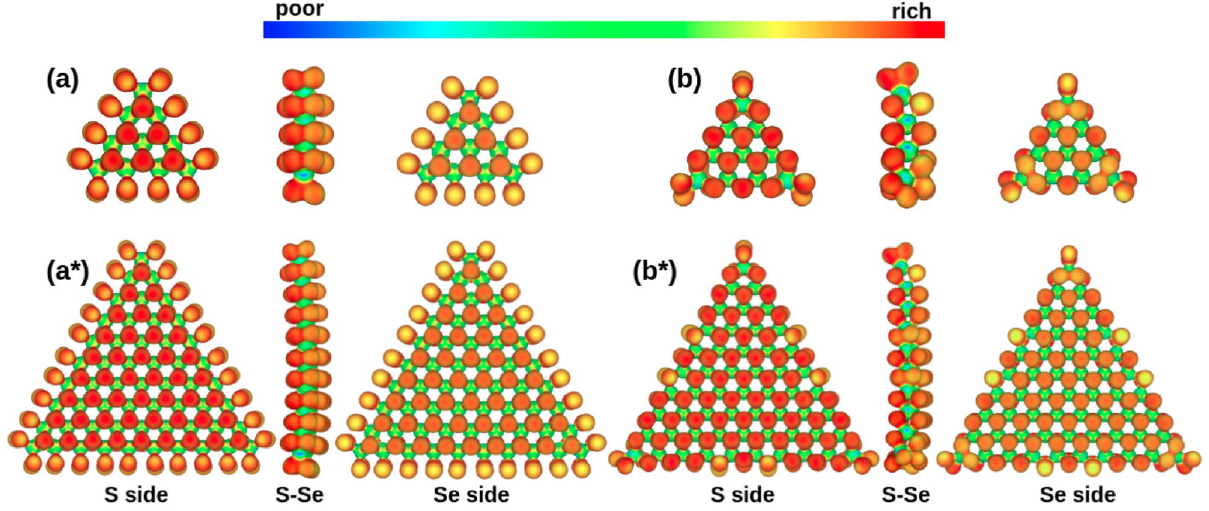
Figure 6. Electrostatic potential isosurface used to visualize electron rich areas on the more stablest structures. ( a ) C1(4), ( a* ) C1(10), ( b ) C2(4), ( b* ) shifted 0.1 Åin height generates this signal. On the other hand, for the Se side, it can be seen that excluding the Se atoms that decor the edge forming S–Se dimers, a triangular structure emerges that appears to be framed by the border with greater height. The brim contribution of this inner triangle is higher than the edge for all the triangles distribution. These sections are consistent with our previous analysis of geometrical distortion. The evidence presented is a clear indication that the curvature of the structure is generated towards the side of the sulfur face in both systems. Moreover, the brim regions bring insight into the differential catalytic activity